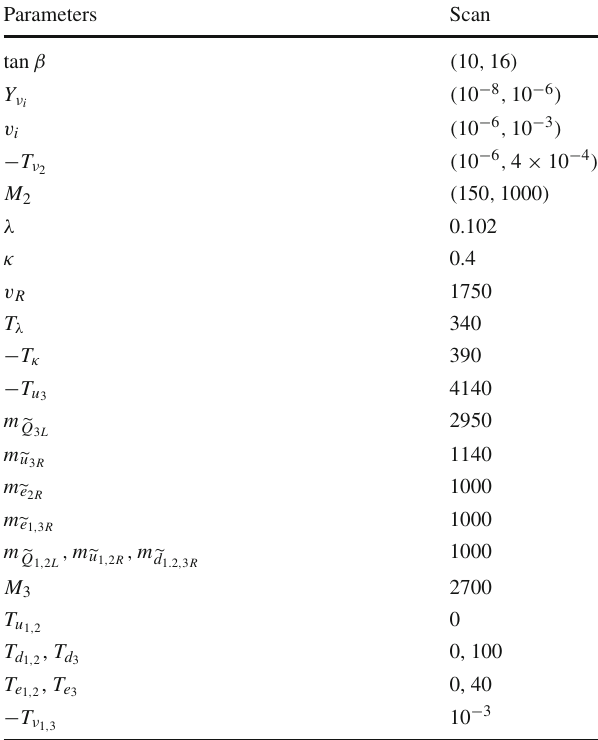
Table 1 Low-energy values of the input parameters in the scan dis- cussed in Case (1) of the text. Soft SUSY-breaking parameters and vevs are given in GeV